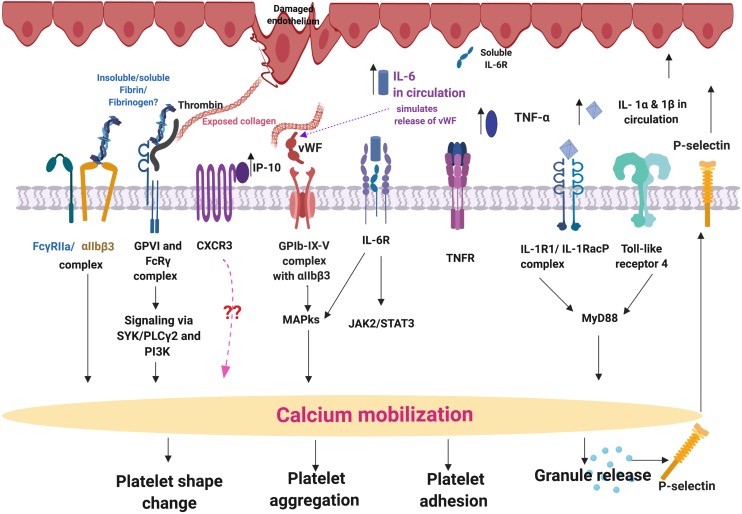
Simplified platelet signaling and receptor activation with main dysregulated molecules IL-1α, IL-1 β, TNF-α, and IL-17A. When inflammatory molecules are upregulated in circulation, they either cause direct endothelial damage (by binding to receptors on endothelial cells), or they may act as ligands that bind directly to platelet membrane receptors (Olumuyiwa-Akeredolu et al., 2019). When these inflammatory molecules disrupt endothelial cell structure, the endothelial cells release collagen and von Willebrand Factor (vWF). vWF is also a mediator of vascular inflammation (Gragnano et al., 2017), and it binds to exposed collagen and anchors platelets to the subendothelium (Du, 2007), causing platelet aggregation (Xu et al., 2016), and formation of a platelet plug (Jagadapillai et al., 2016). Both collagen and vWF act as platelet receptor ligands, causing platelet outside-in signaling, followed by inside-out signaling. Furthermore, collagen and vWB binding also result in signaling processes that cause a release of stored molecules that are present inside α- and dense granules of platelets, and may also include stored interleukins (e.g., IL-6 and IL-1β); further increasing the concentration of these inflammatory molecules in circulation (Olumuyiwa-Akeredolu et al., 2019). vWF binding is mediated by GpIbα (which is part of the GPIb-IX-V) and integrin (αIIbβ3 complex (Bryckaert et al., 2015). This αIIbβ3 receptor also binds fibrinogen and thrombin, and both these molecules and vWF work together to play critical roles in platelet activation and aggregation (Estevez and Du, 2017). Diagram created using BioRender (https://biorender.com/).